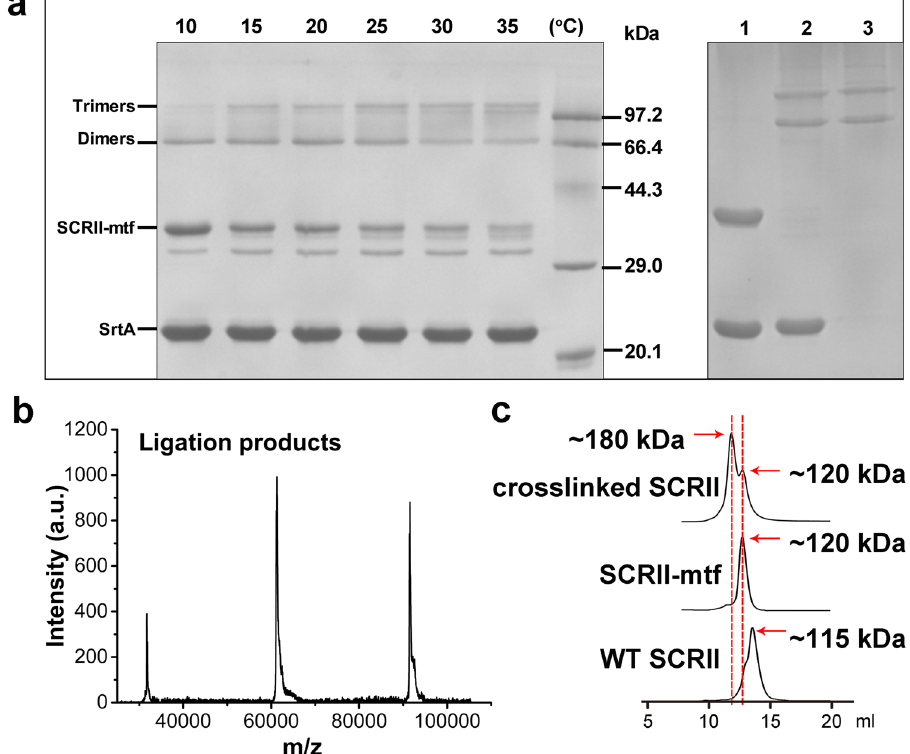
Figure 2. Determination of SrtA-mediated ligation products. ( a ) Left: Optimization of the temperature for the SrtA-mediated ligation. SCRII-mtf and SrtA were incubated at different temperatures for 8 h. Right: Ligation result after 36 h for WT SCRII and SCRII-mtf. Lanes 1 and 2, WT SCRII and SCRII-mtf were incubated with SrtA for 36 h at 25 °C, respectively. Lane 3, Purified crosslinked SCRII. ( b ) MALDI-TOF-MS analysis